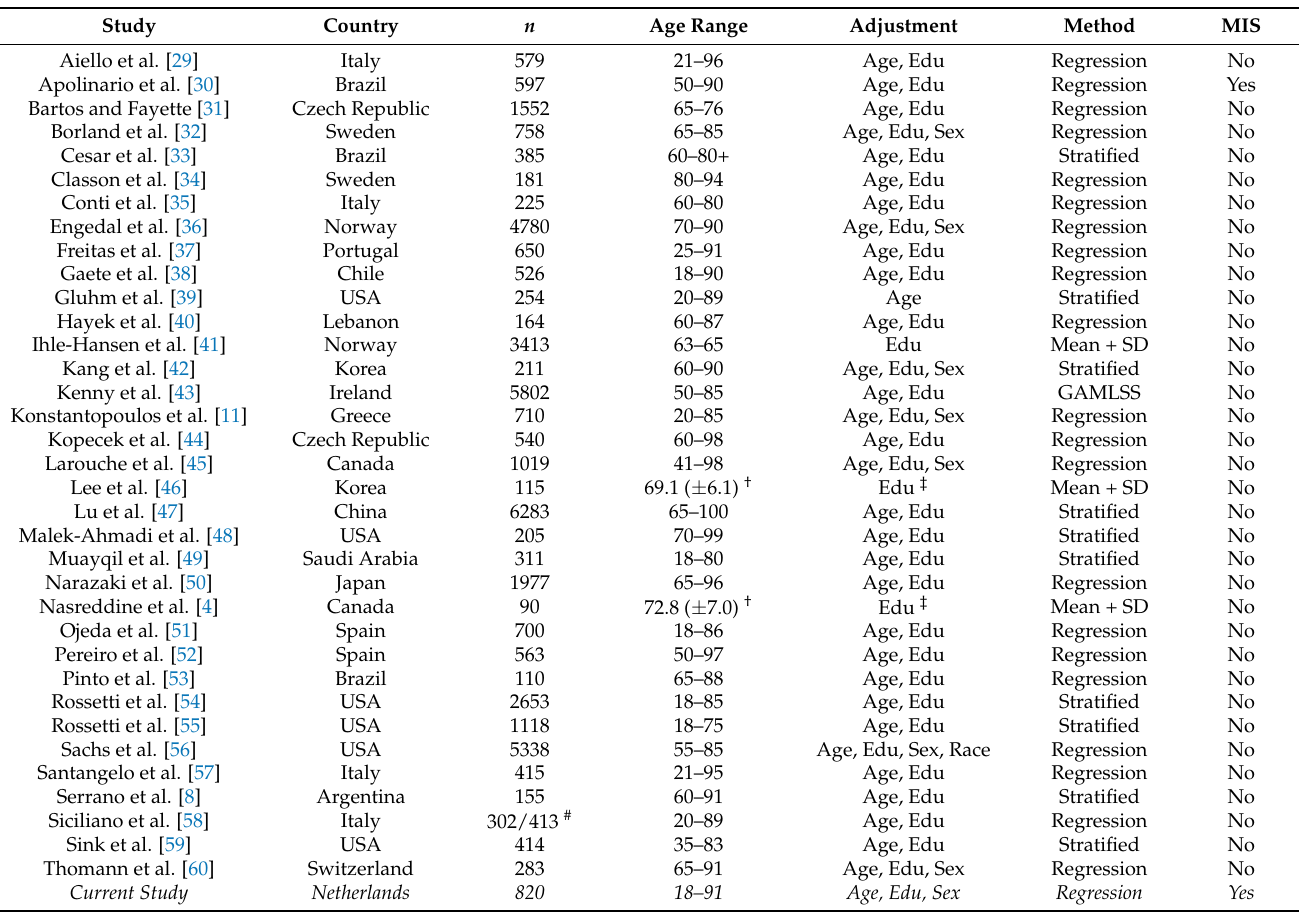
Table 1. Overview of available normative data for international versions of the Montreal Cognitive Assessment